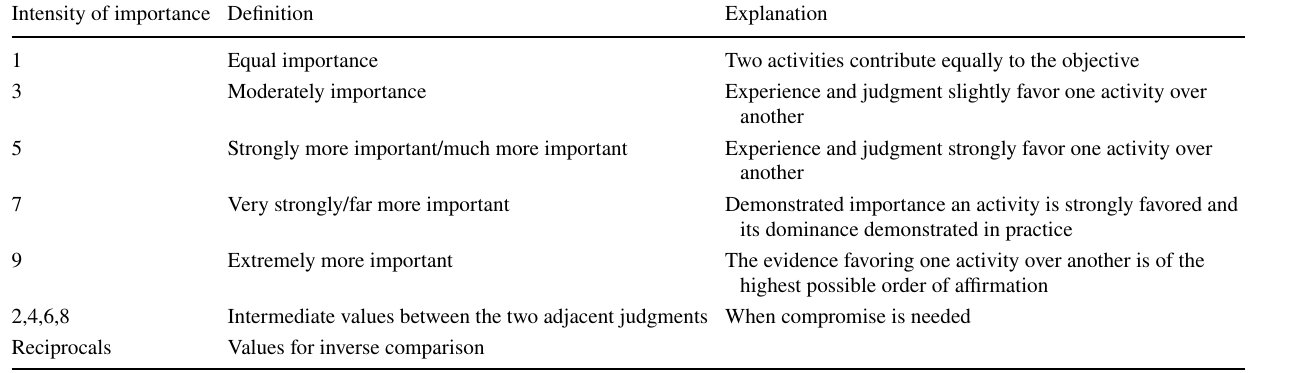
Table 4 Saaty’s scale of relative importance (Saaty, 1980; Saaty and Vargas 1991) Intensity of importance